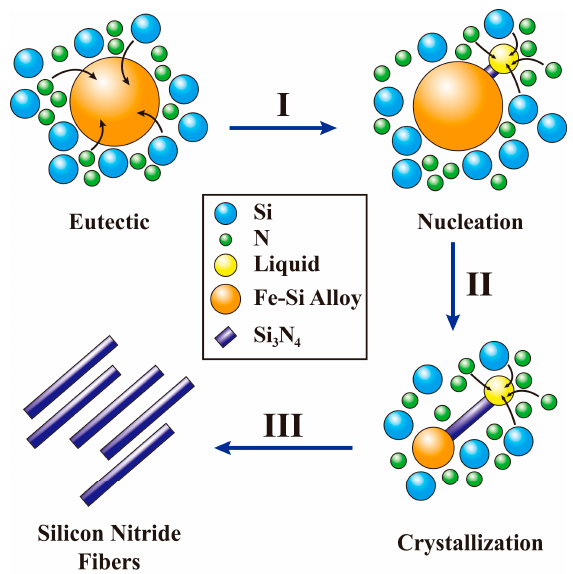
Figure 6 . Schematic diagram for the growth of α‐ Si 3 N 4 fibers. Figure 6. Schematic diagram for the growth of α -Si 3 N 4